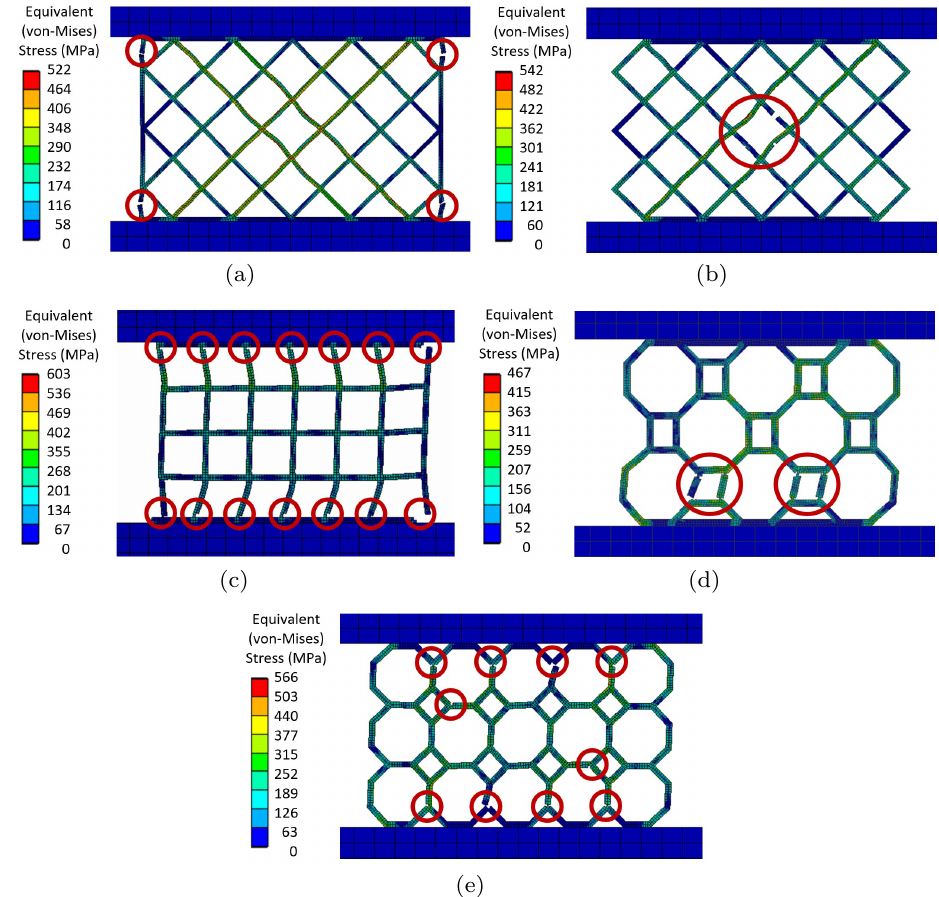
Figure 6. Failure modes of SPSYDs ( a ) P1 [6th cycle], ( b ) P2 [11th cycle], ( c ) P3 [27th cycle], ( d ) P4 [18th cycle] and ( e ) P5 [22nd